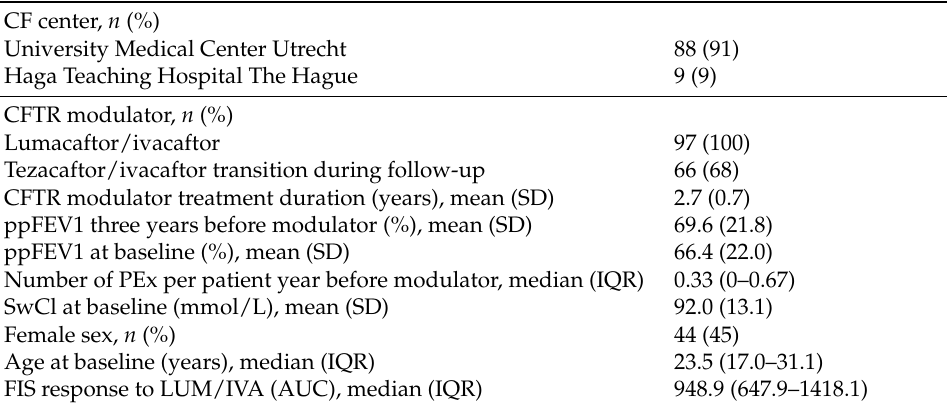
Table 1. Baseline characteristics of the study population ( n =